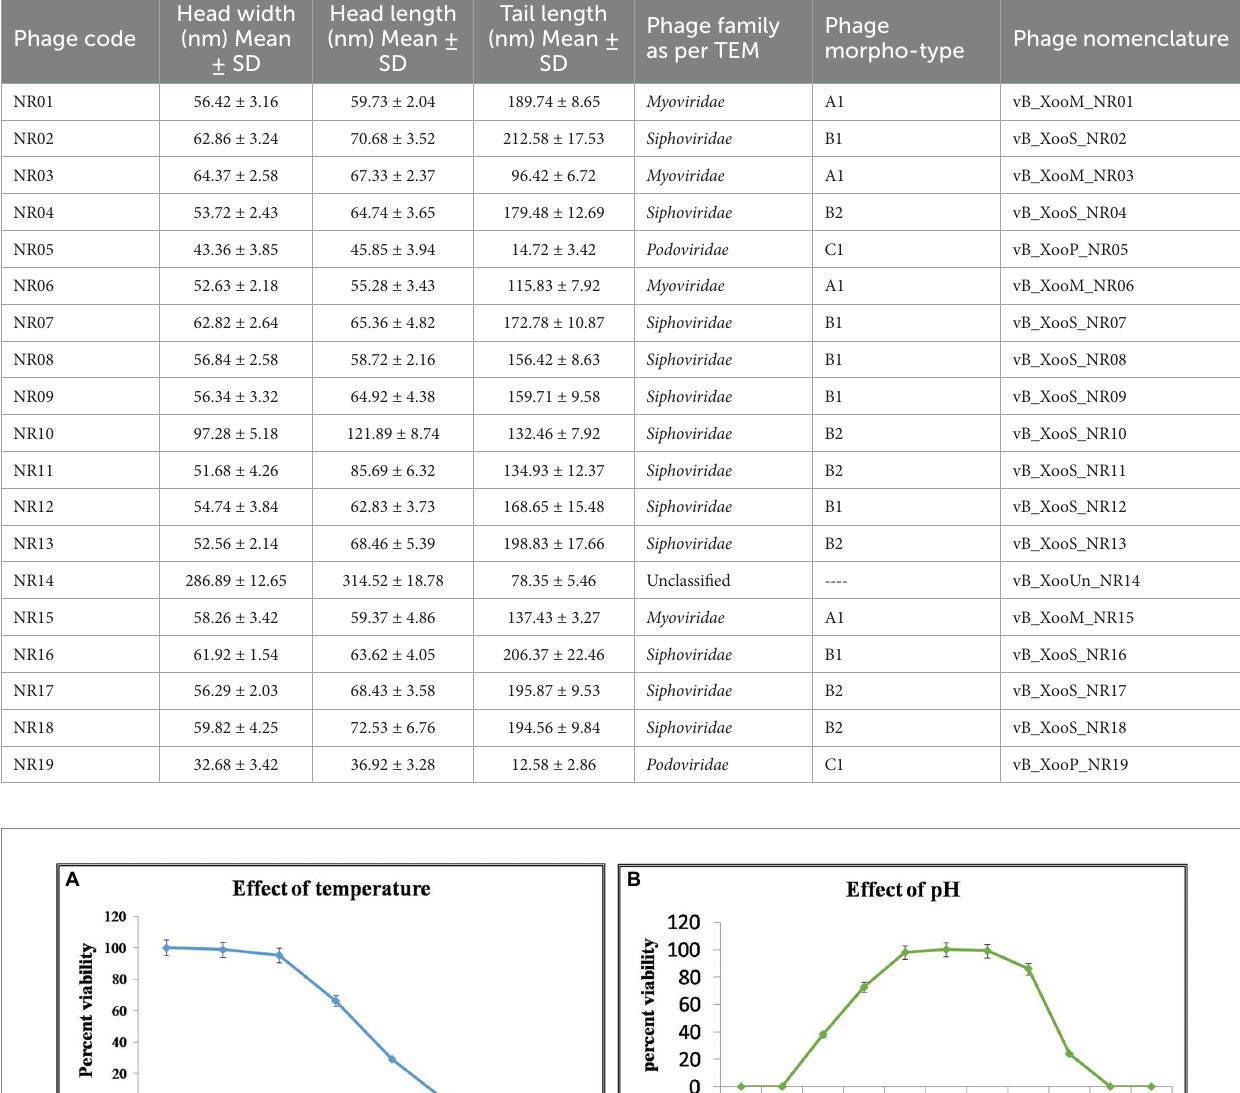
TABLE 2 Morphology details and nomenclature of phage on the basis of transmission electron microscopy.